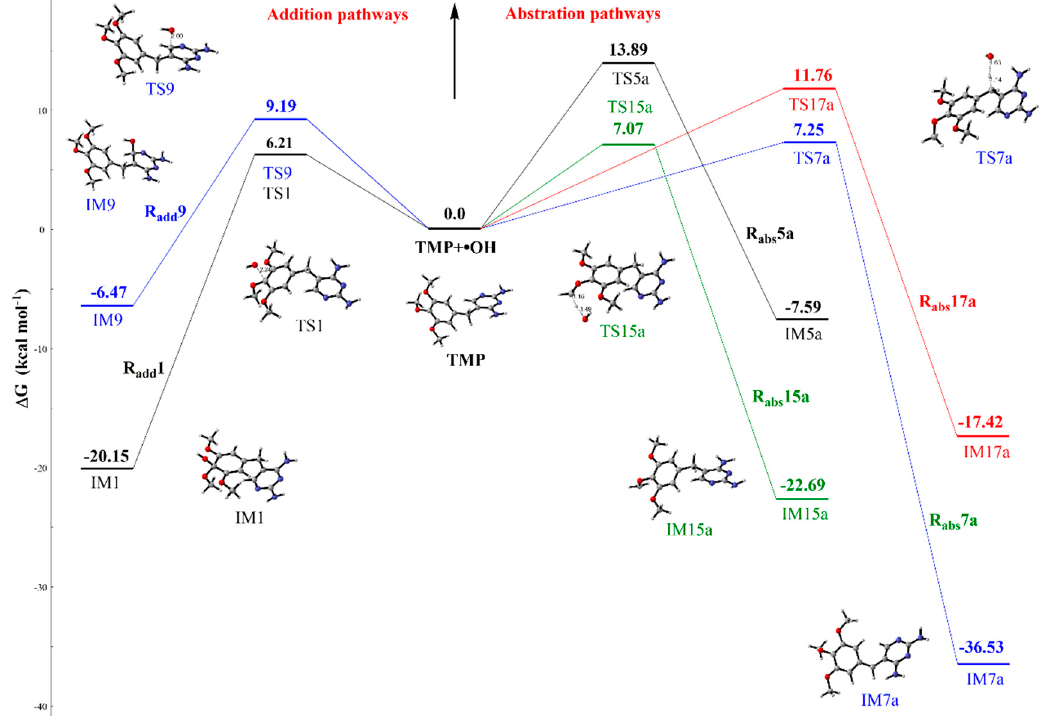
Figure 3. Schematic diagram of free energy for the reactions of TMP with •OH at different sites at the M06-2X/6–31+G (d, p) level.